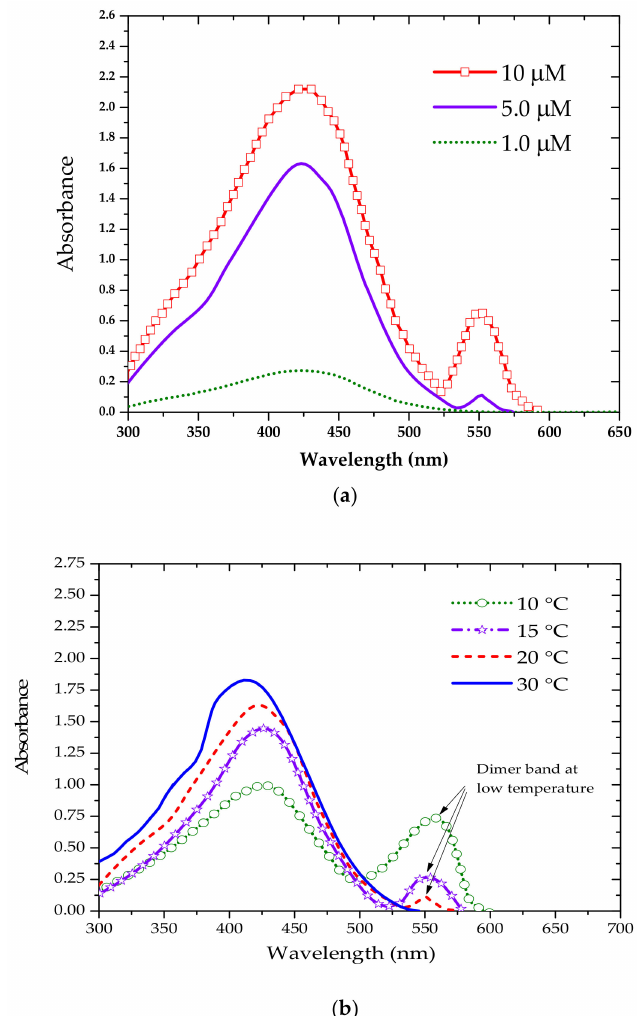
Figure 2. ( a ) Absorption spectra of TCP in benzene for different concentration at 20 ◦ C; ( b ) Absorption spectra of 5 µ M solution of TCP in benzene at different